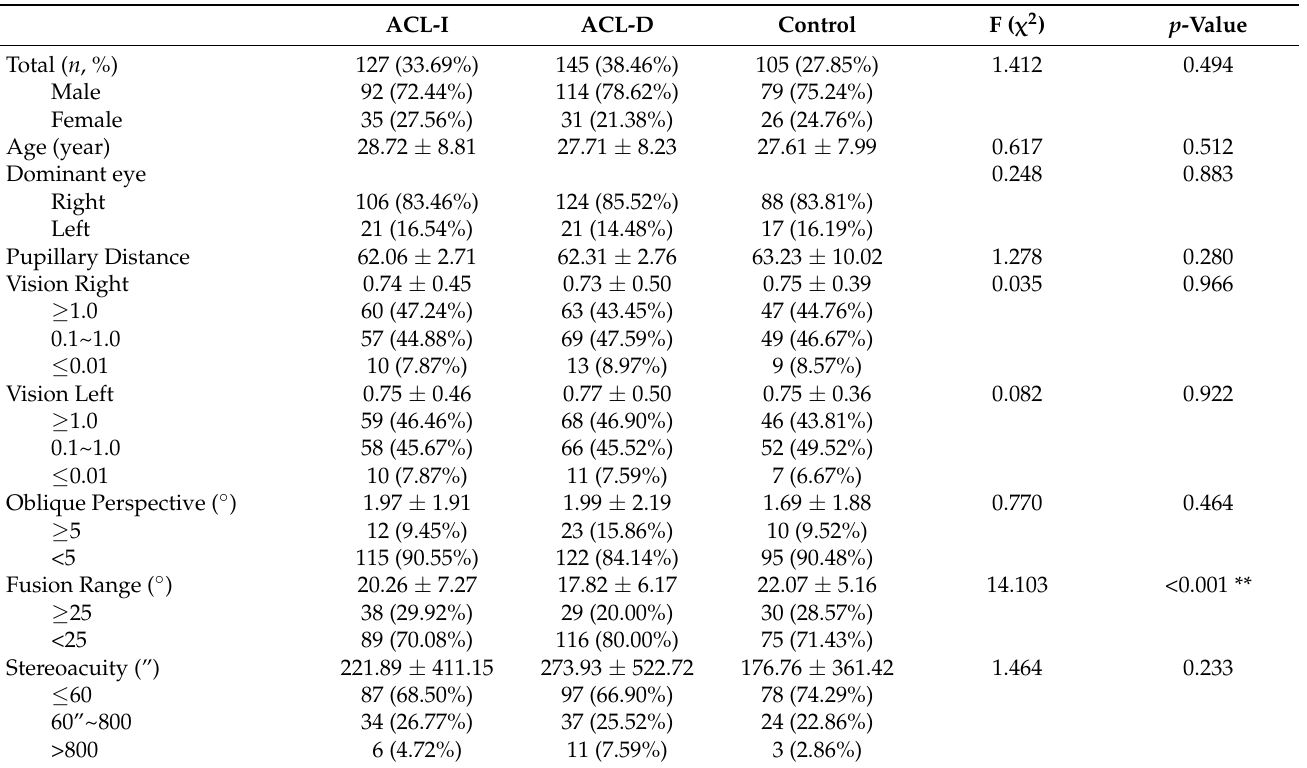
Table 4. Statistical description of 377 visual examination